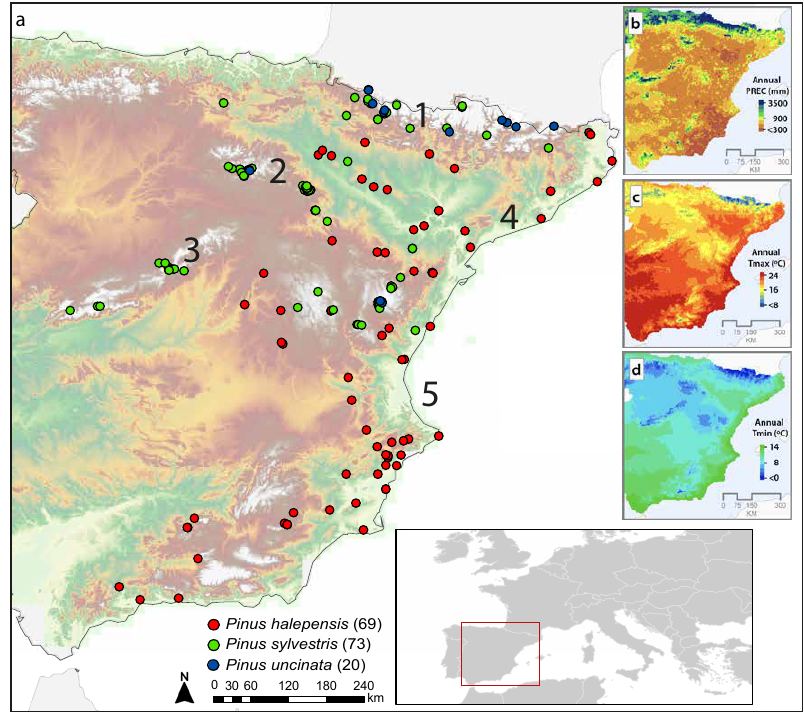
Figure 1. ( a ) Location of the dendrochronological network (162 sites). ( b ) Annual mean precipitation for the 1950–2012 period. ( c ) Annual mean maximum temperature. ( d ) Annual mean minimum temperature. Numbers refer to different toponyms: (1) Pyrenees, (2) Iberian System, (3) Central System, (4) Catalan Coastal Range, and (5) the Mediterranean